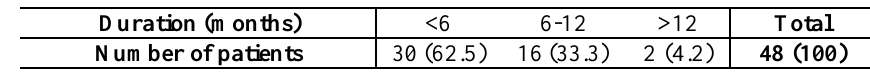
Table III : Duration of the disease (from onset to